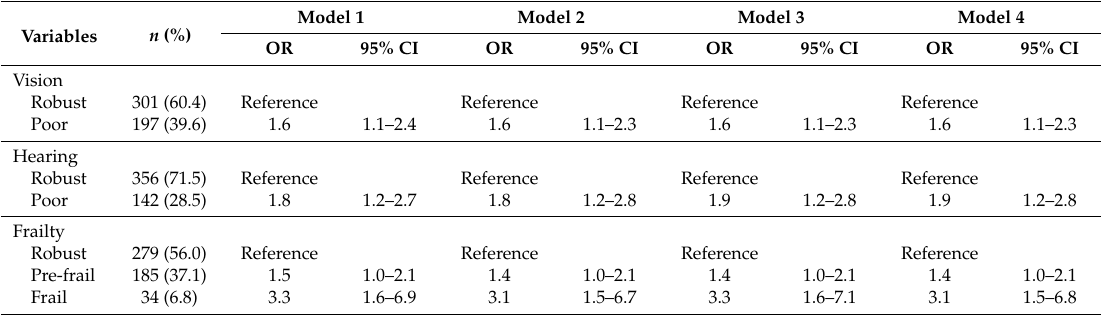
Table 4. Associations of sensory impairment and frailty with improvement in incident SMCs after 12 months ( n = 498).